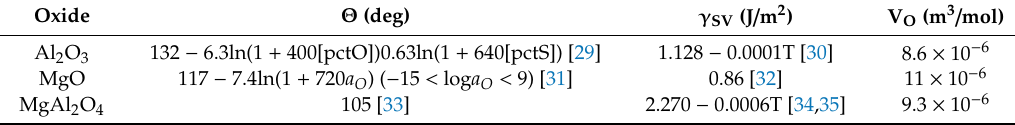
Table 5. Equilibrium constants used in this study.